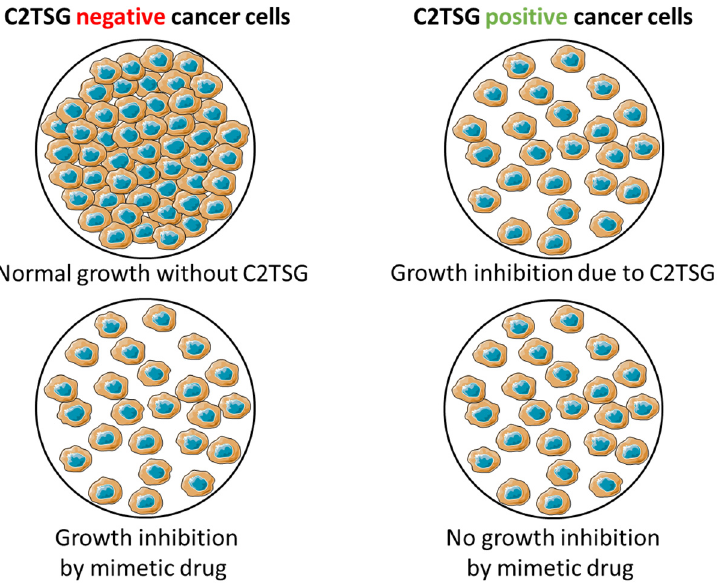
Figure 6. General principle of screening for mimetic drug candidates based on the CellTiter-Glo ® Assay. Cancer cell line lacking C2TSG protein exhibits normal growth characteristics ( top left ), while cancer cell line with forced C2TSG protein re-expression exhibits growth inhibition ( top right